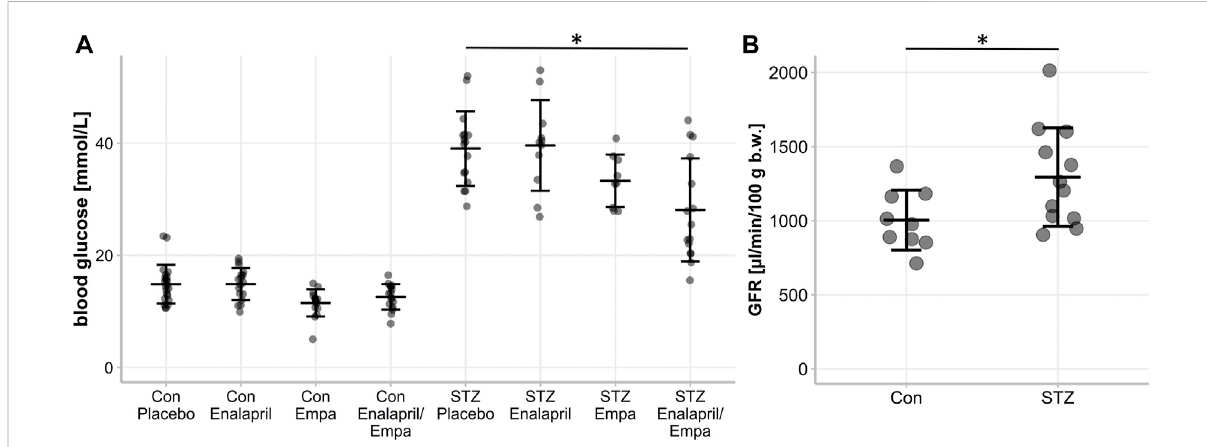
FIGURE 1 Blood glucose level and glomerular fi ltration rate (GFR) of non-diabetic control mice and STZ-diabetic mice. Effect of enalapril, empagli fl ozin (Empa), and enalapril/empagli fl ozin (Enalapril/Empa) treatment on (A) blood glucose and (B) glomerular fi ltration rate (GFR) in controls (Con) and diabetic (STZ) mice. For statistical differences an one-way ANOVA was performed in (A) , n = 9-22, and an unpaired t -test in (B) , n = 9-13.Values are expressed as mean ± SD. p <